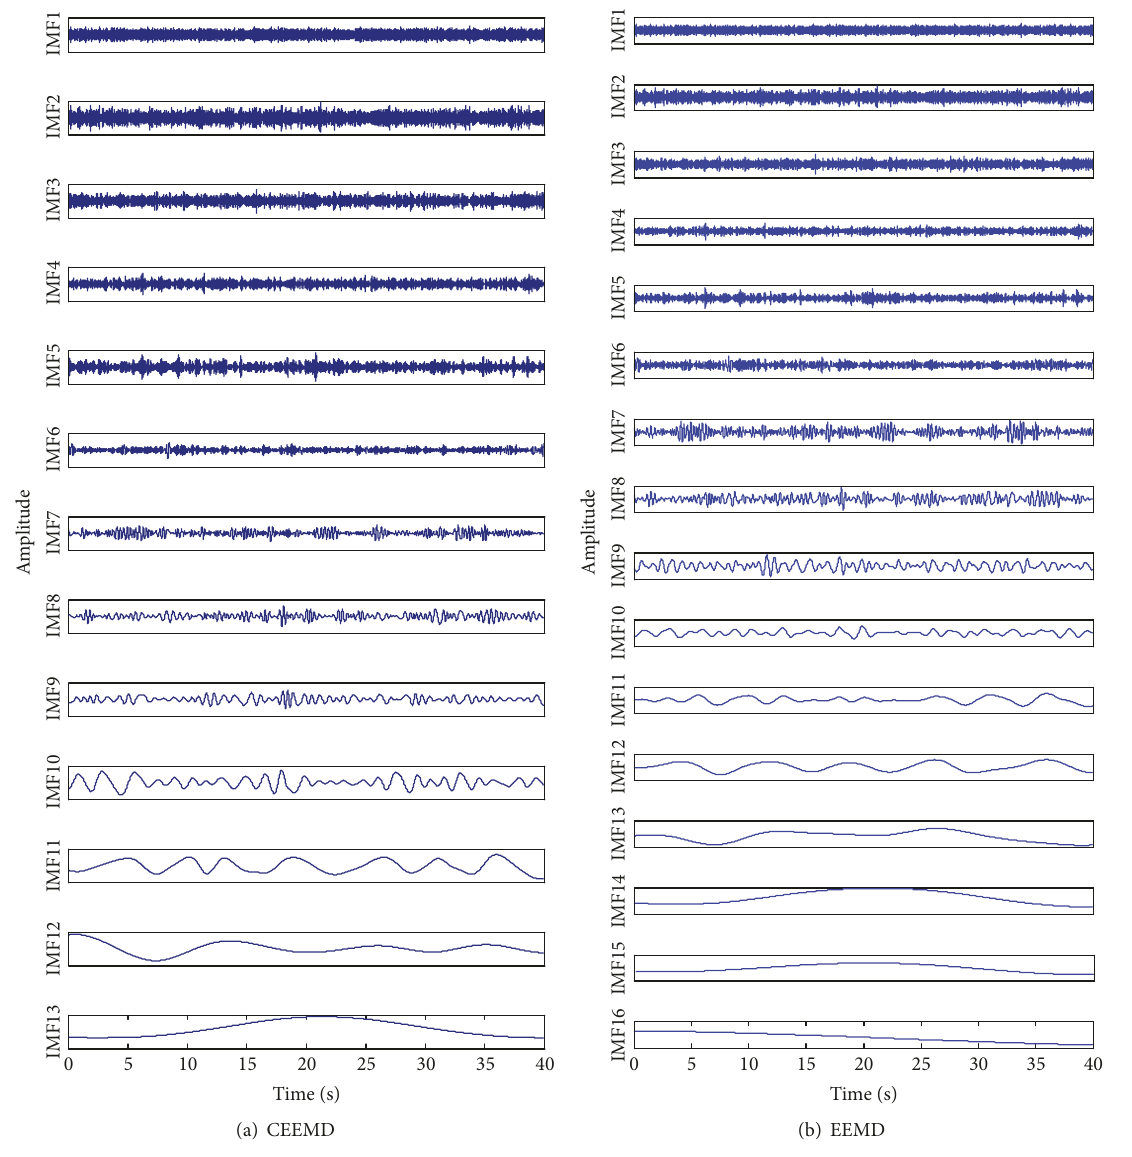
Figure 8: Signal decomposition of Stage